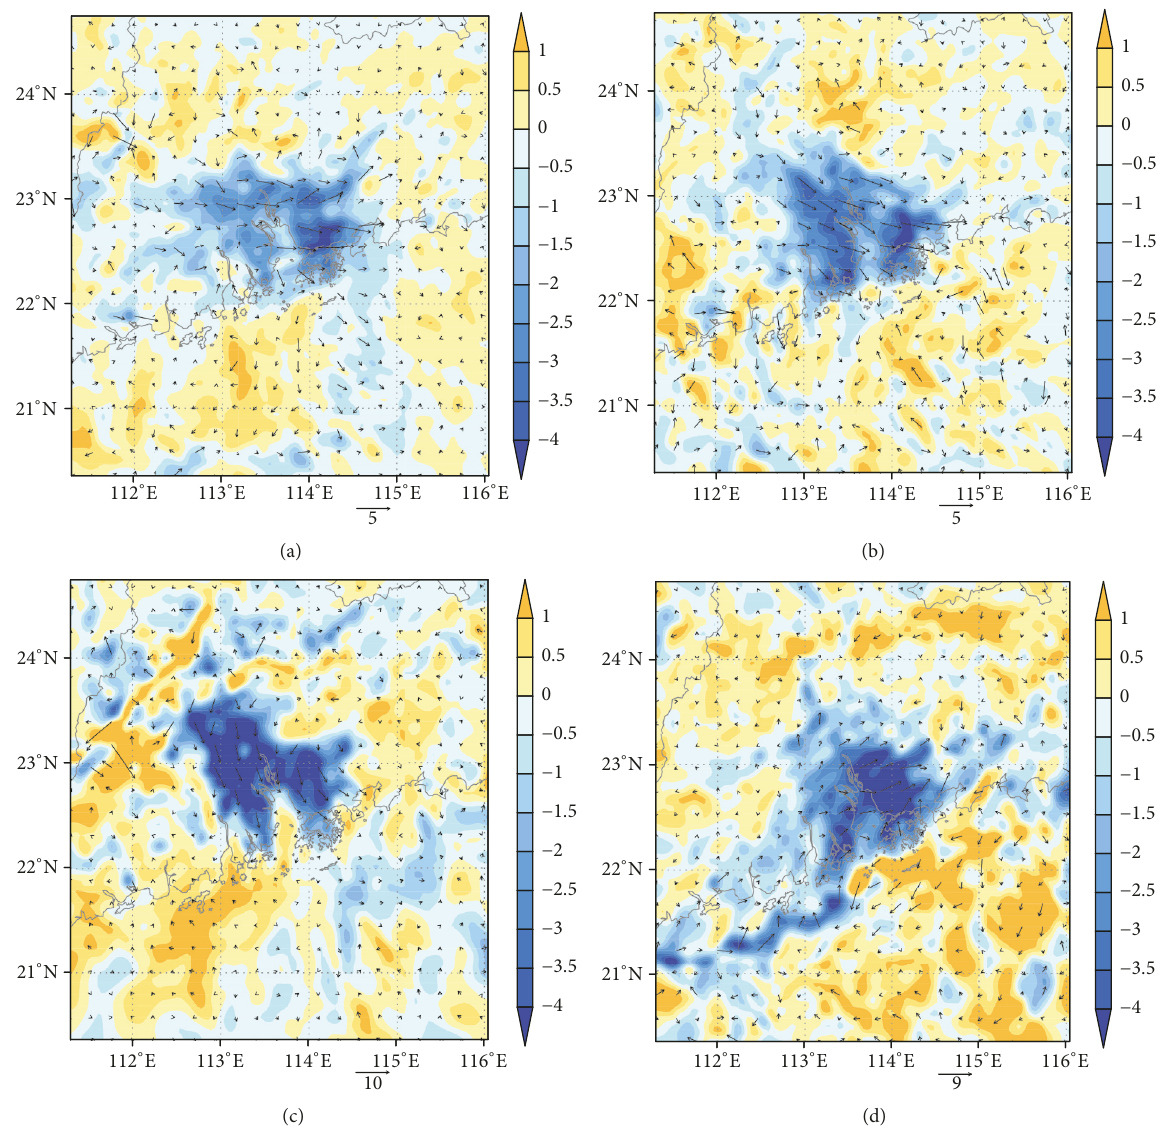
Figure 3: Differences of 10m wind and wind speed (choropleth map, unit: m s −1 ) between URBAN and PRE-URBAN test (URBAN minus PRE-URBAN) for daytime (06:00 UTC) and nighttime (18:00 UTC), during 1-2 January 2010. (a) 06:00 on 1 January, (b) 18:00 on 1